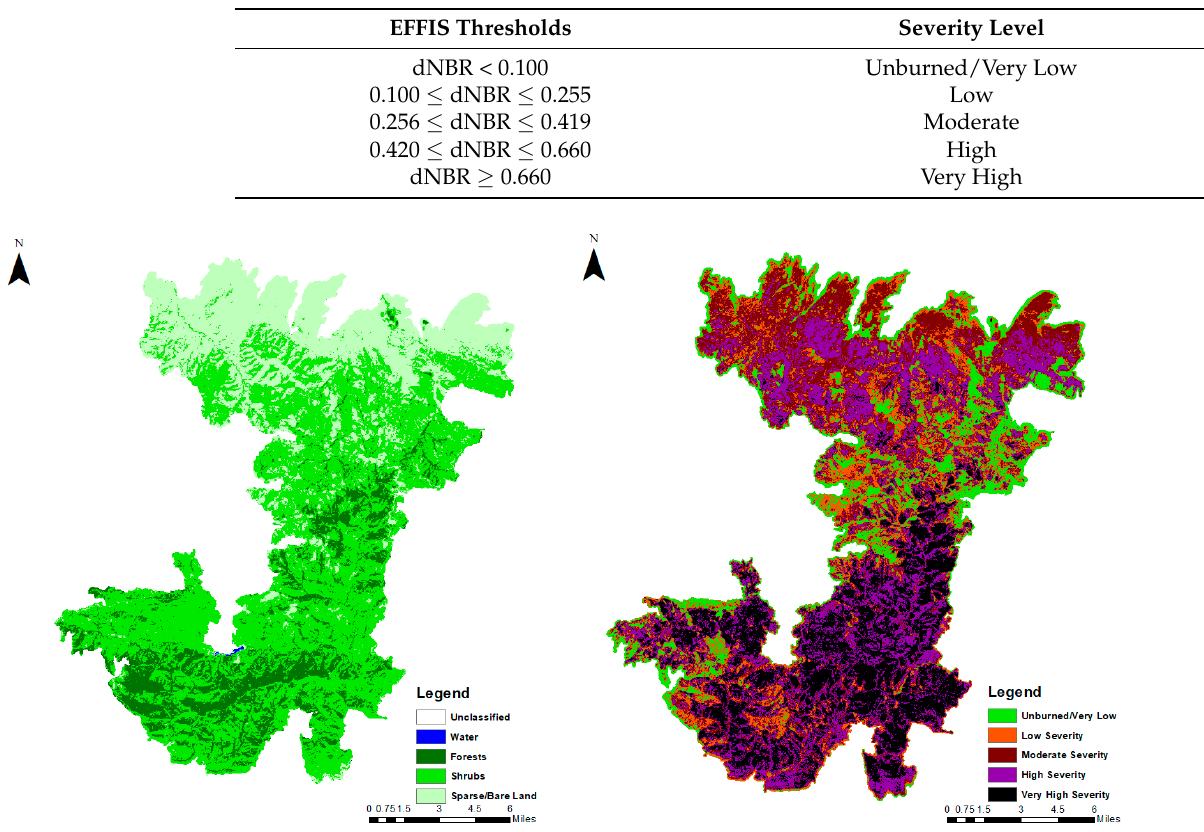
Figure 5. Classification map of vegetation community and burn severity.